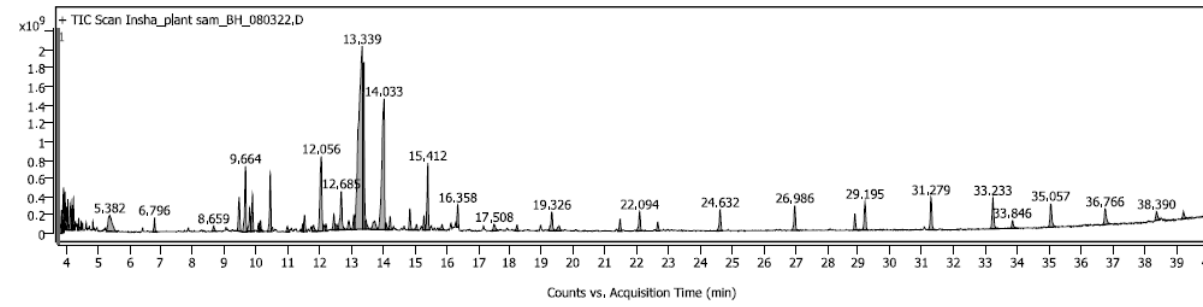
Figure 4. GC-MS/MS chromatogram of HECl.